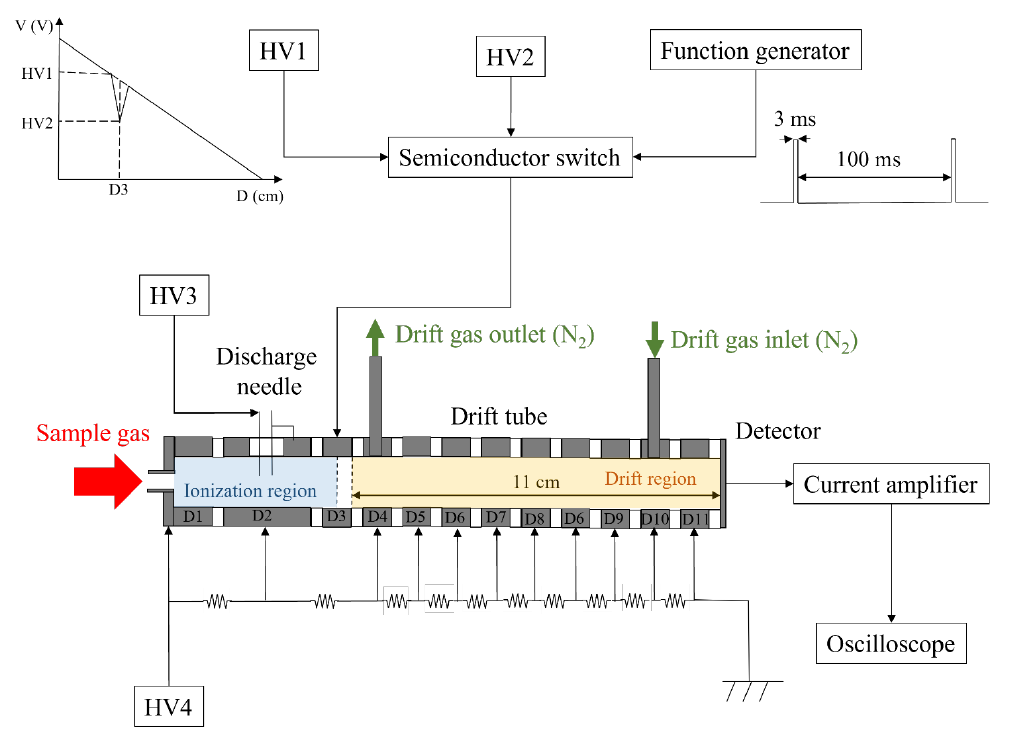
Figure 1. Schematic diagram of the experimental apparatus. Sample vapor is ionized by corona dis- charge from a high-voltage (HV) supply (discharge needle = 4.7 kV and 2.6